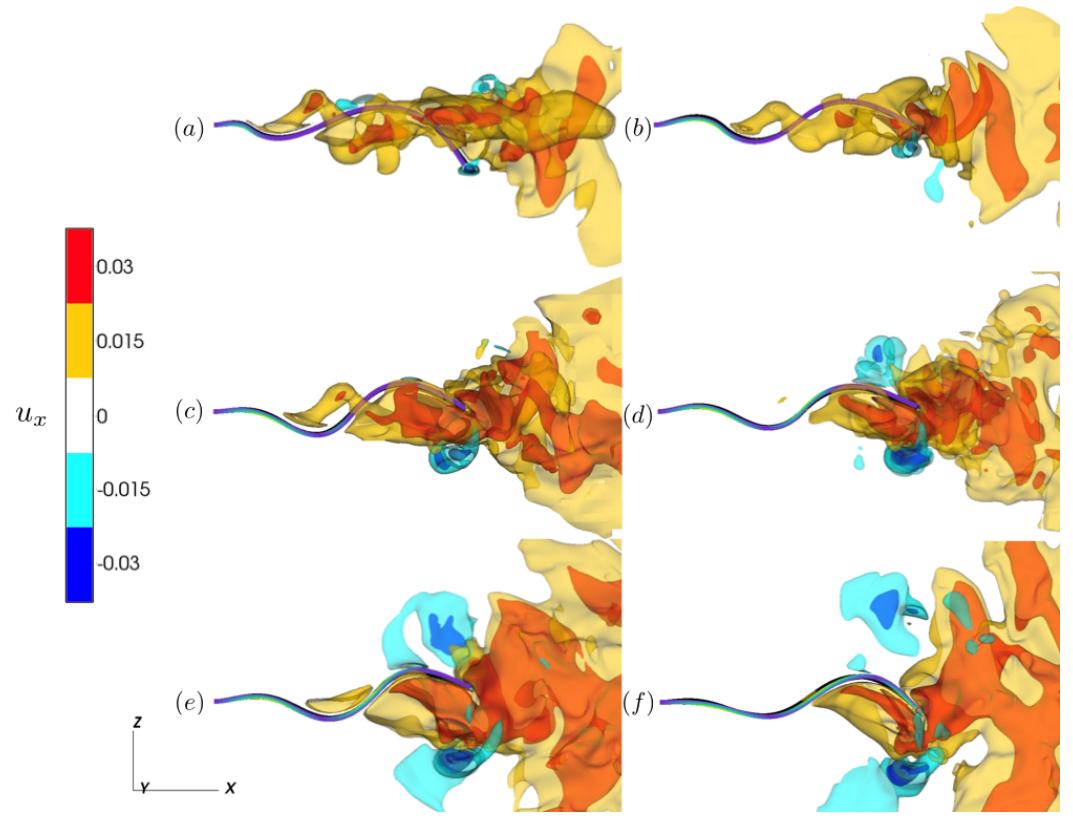
Figure 4. Isocontours of u x at time t = 10.0 for A = ( a ) 1 instantaneous strength of contraction ( γ